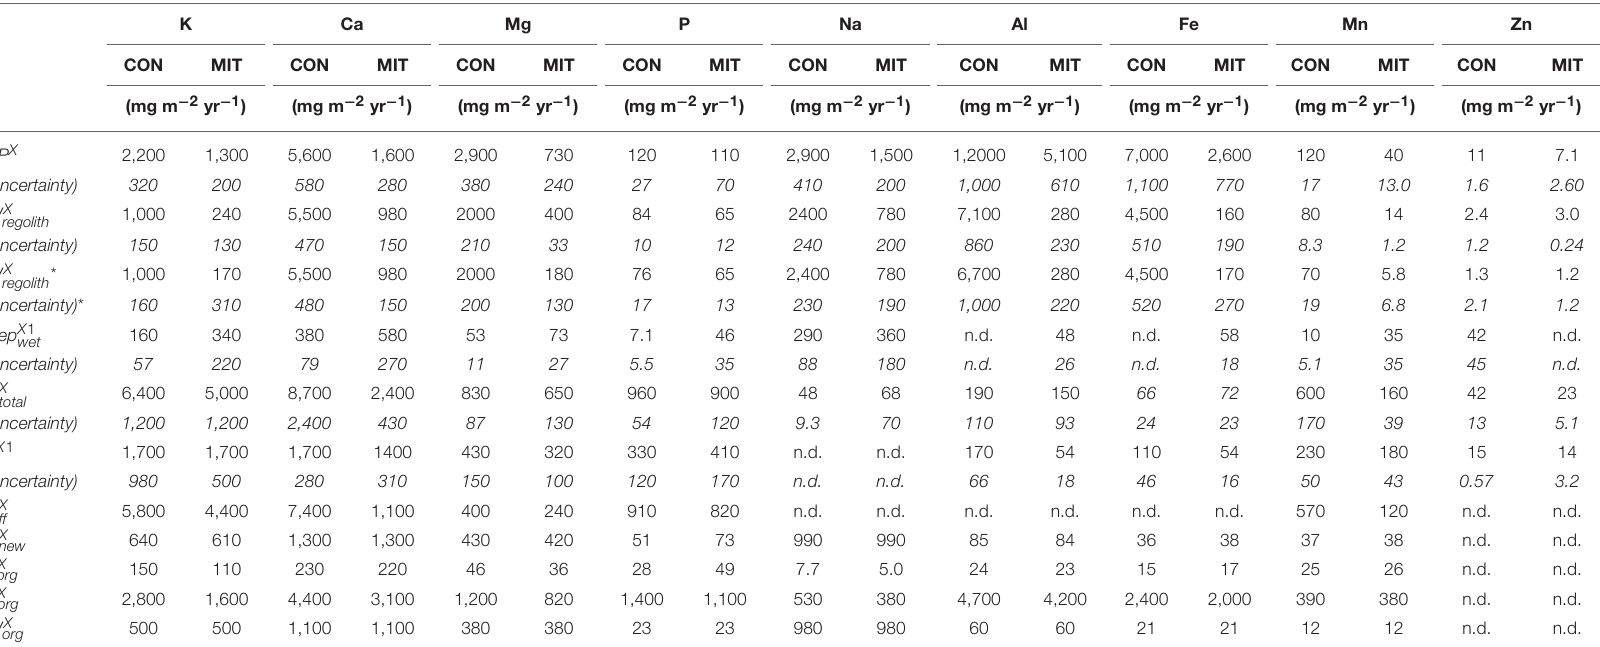
TABLE 3 | Elemental fluxes at CON and